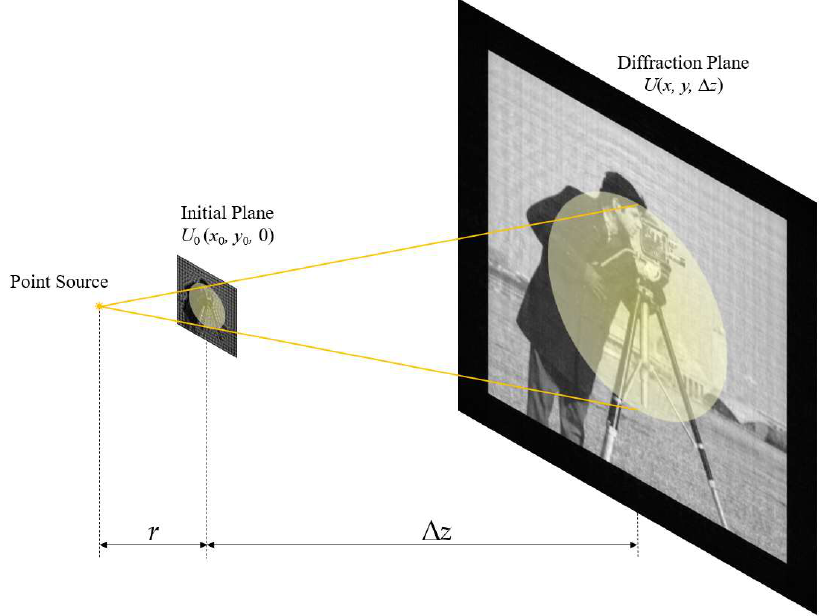
Figure 1. Schematic of the diffraction imaging